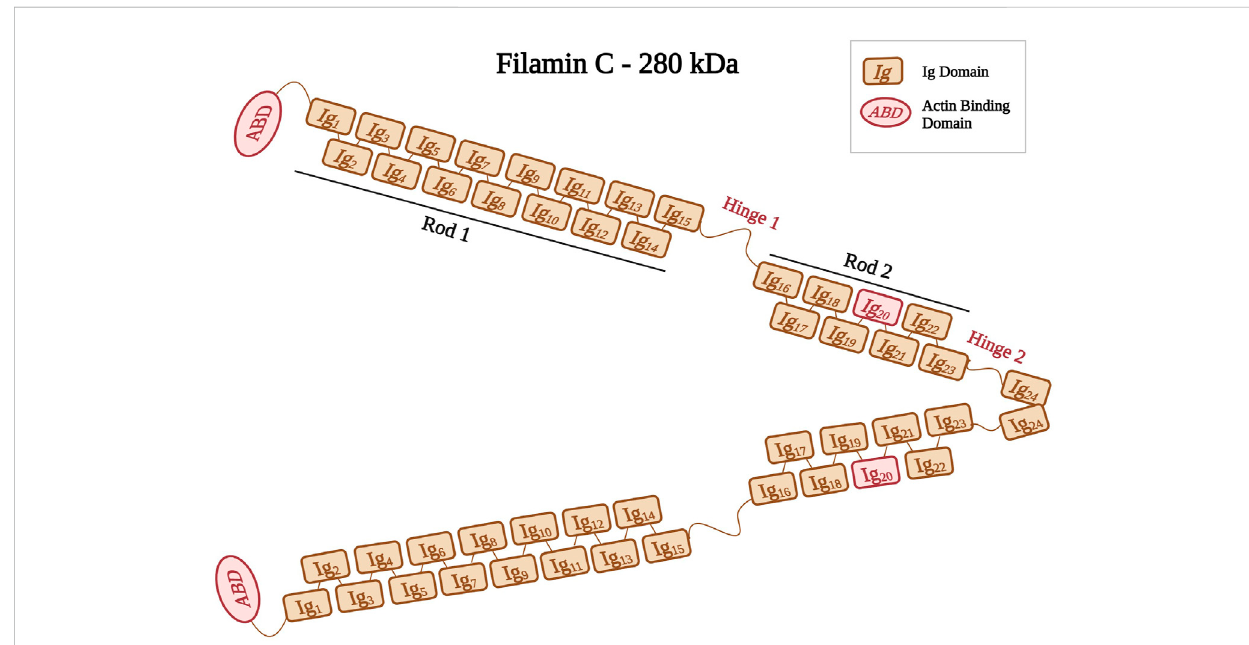
FIGURE 3 Schematicrepresentationof fi laminCshownasadimerwithdifferentIgdomainsformingbothRods(Rod1,Ig1toIg15;Rod2,Ig16toIg23).Positions of hinges one and two are also indicated. Ig20 is highlighted in red because of its unique 80 amino acid insertion. Created with